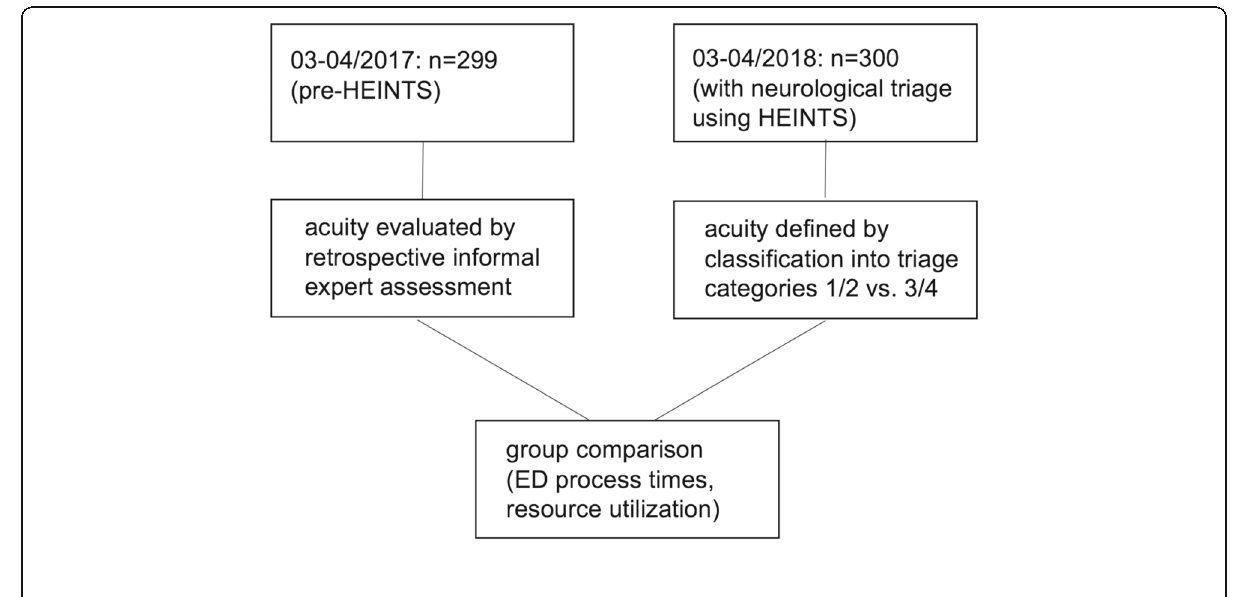
Fig. 2 Overview of methods. ED = emergency department, HEINTS=Heidelberg Neurological Triage